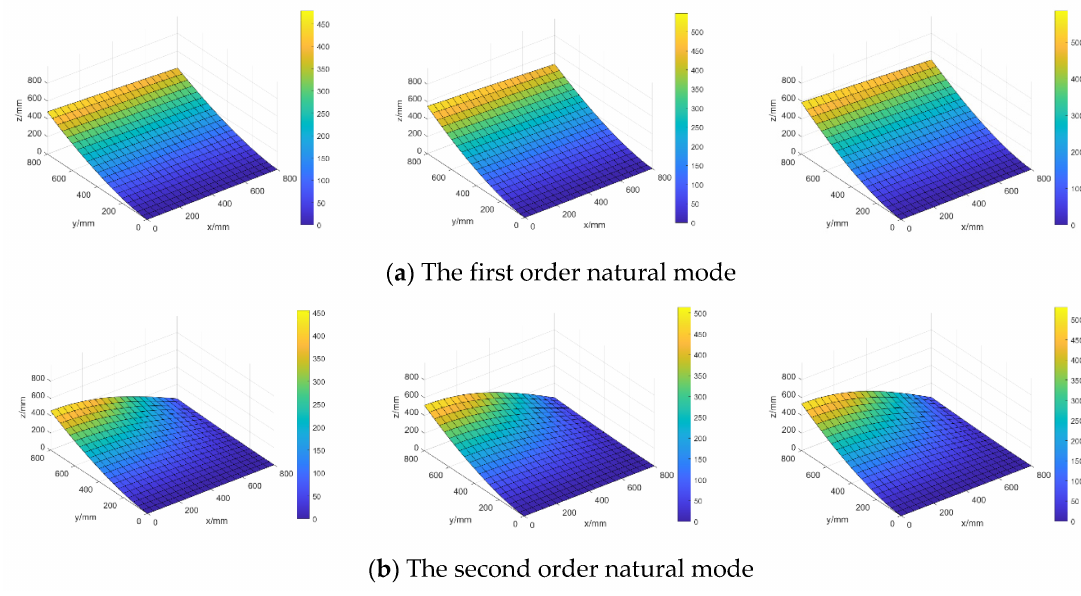
Figure 16. The distributions of lower bound ( left ), mean value ( middle ), and upper bound ( right ) of random natural modes when only considering random field E .